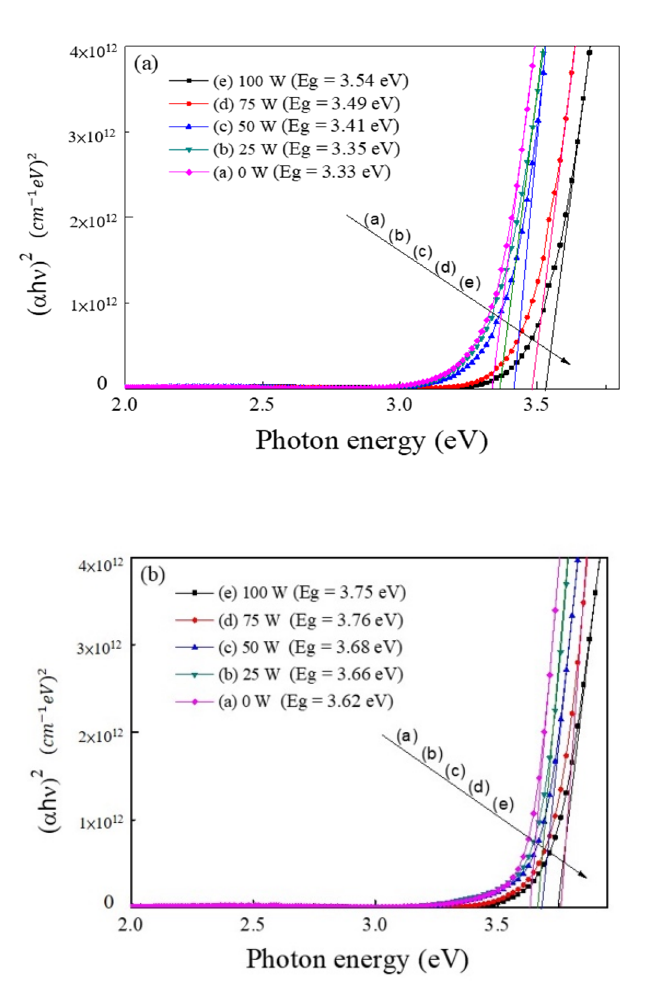
Figure 4. The ( α h ν ) 2 versus h ν plots of the studied films ( a ) as-deposited state and ( b ) isothermally Figure 4. The (αhν) 2 versus hν plots of the studied films ( a ) as-deposited state and ( b ) isothermally annealed at a temperature of 600 ◦ annealed at a temperature of 600 °C.